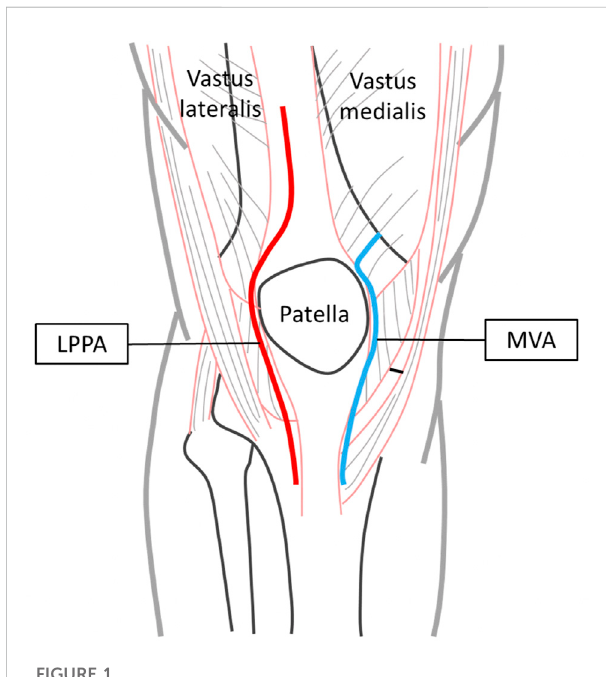
Surgical approaches for TKA — lateral parapatellar approach (LPPA, red line) and mid-vastus approach (MVA, blue